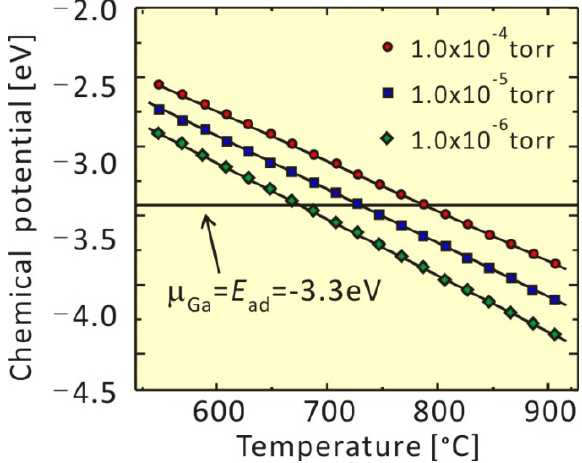
, as a function of temperature. gas